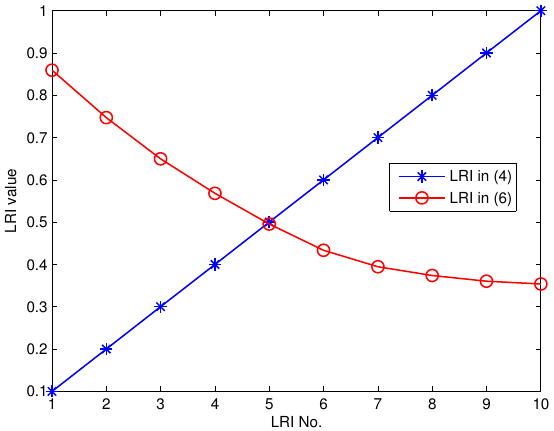
Figure 4. load replaceability index (LRI) with and without optimal scheduling in Scenario 1.